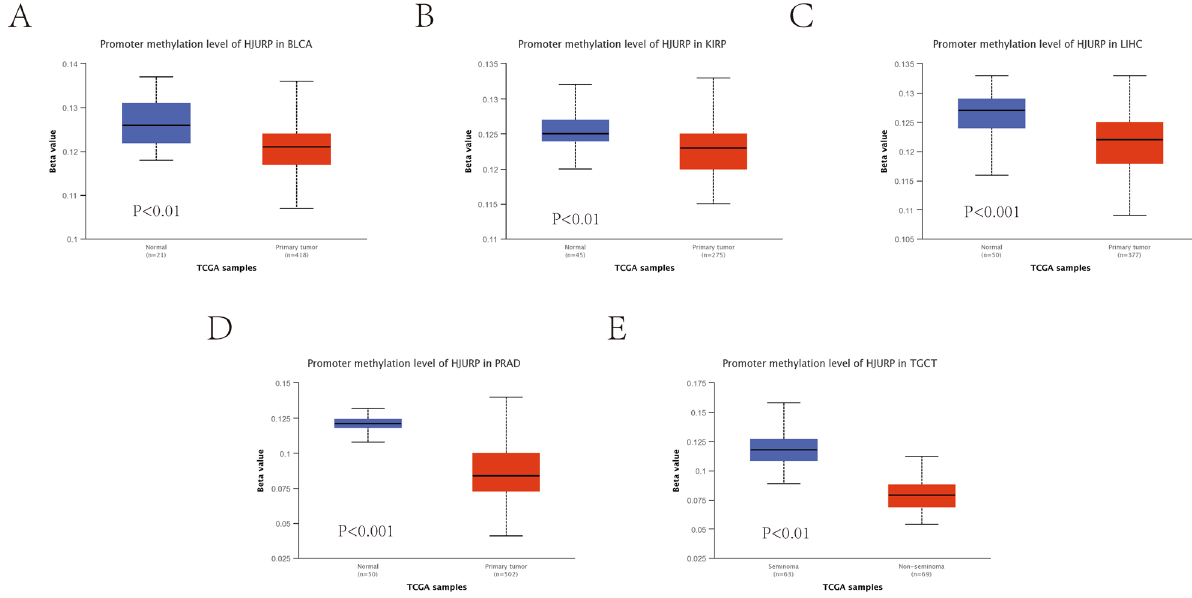
Figure 3. The promoter methylation status chart of HJURP in BLCA, KIRP, LIHC, PRAD and TGCT ( A–E